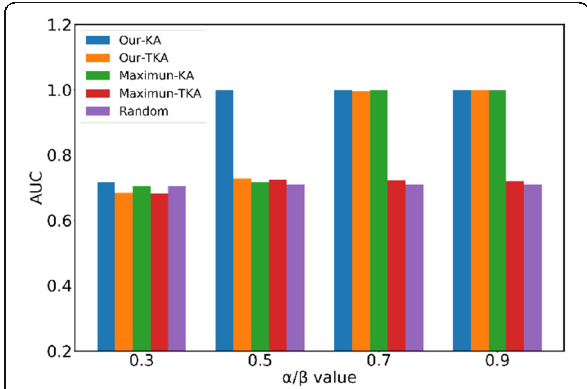
Fig. 6 The different parameters are employed in the weighted similarity function WJC, and λ = 0.3 to obtain AUC values